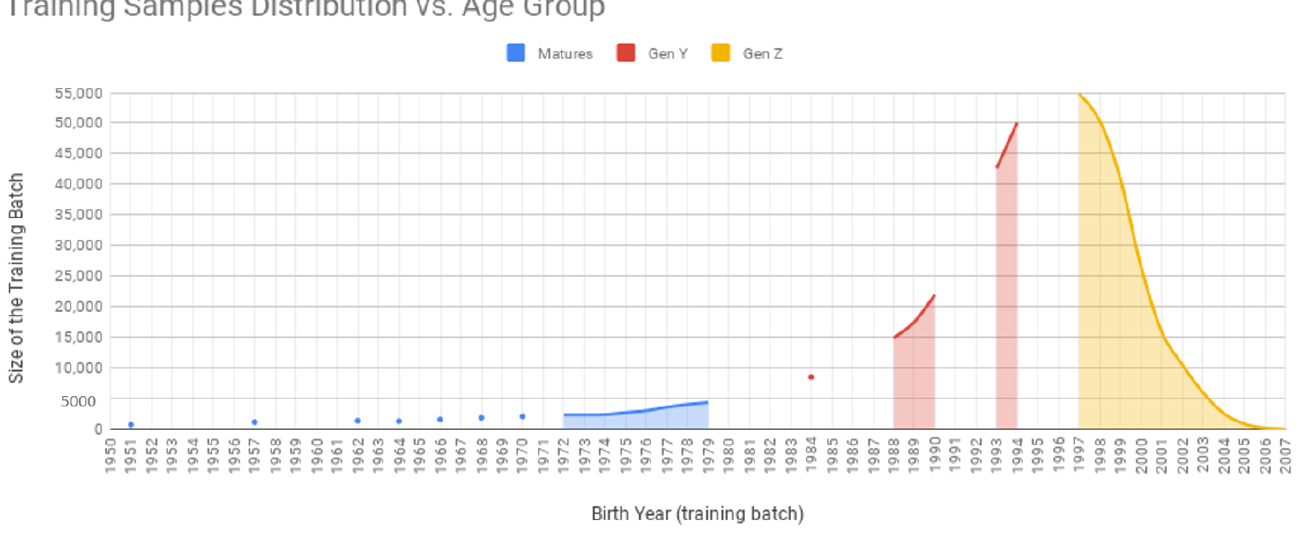
Figure 5. Training samples chosen by AGCL (cf. Table